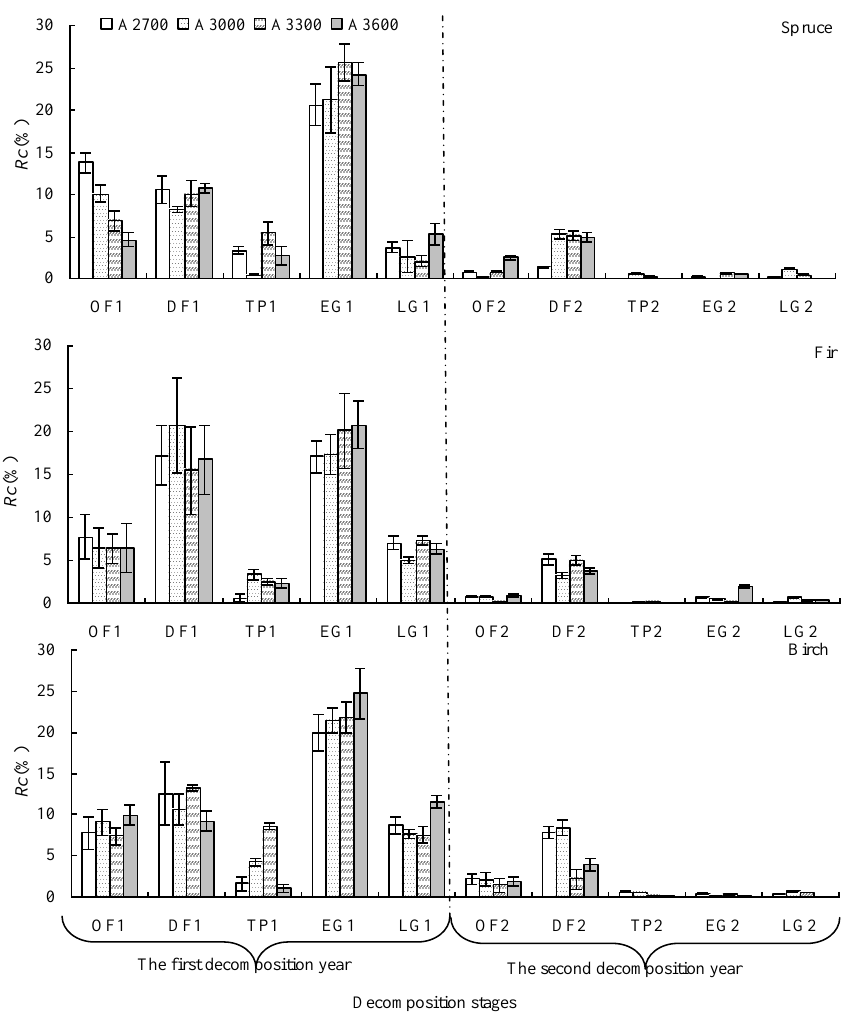
Figure 3. Carbon release rates ( R c ) for foliar litter of the three species investigated (spruce, fir and birch) at four different altitudes and 10 decomposition stages. Bars indicate SE; n =